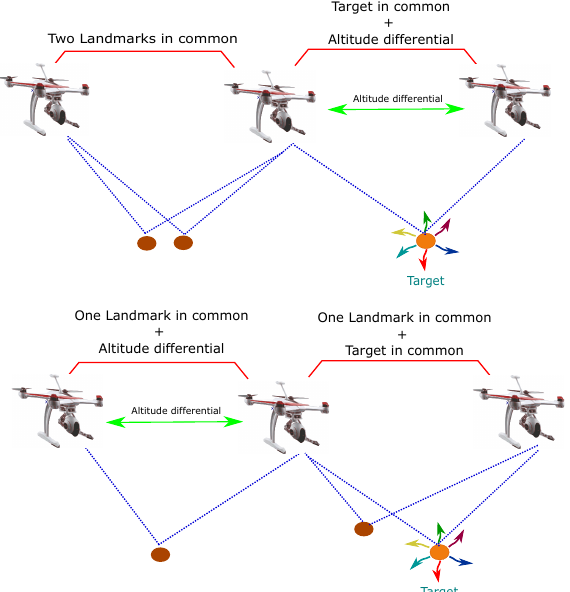
Figure 2. Minimum requirements to obtain the results of the observability analysis for the proposed system in Case 3.